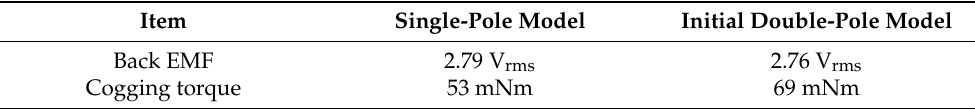
Figure 5. Analysis results of the single-pole and initial double-pole models: ( a ) Back EMF and ( b ) cogging torque.